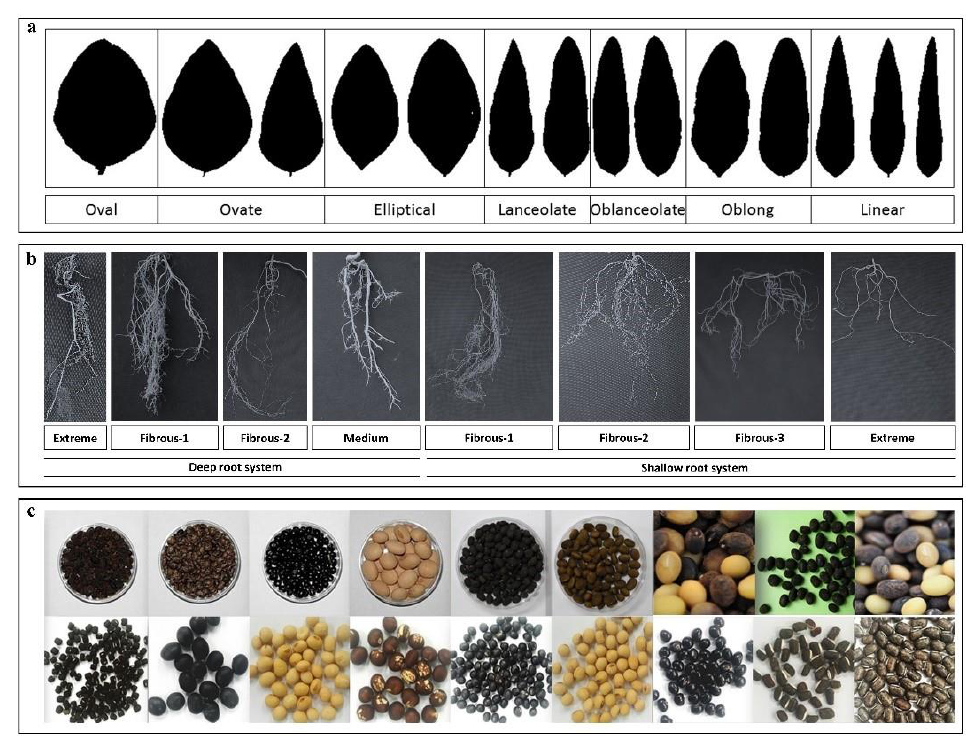
Figure 3. Morphological diversity of soybeans in the CWLGC collection. ( a ) Leaf shape variations in G. soja accessions. ( b ) Root structure variations in G. soja accessions. ( c ) Samples of the legume seed collection at CWLGC.